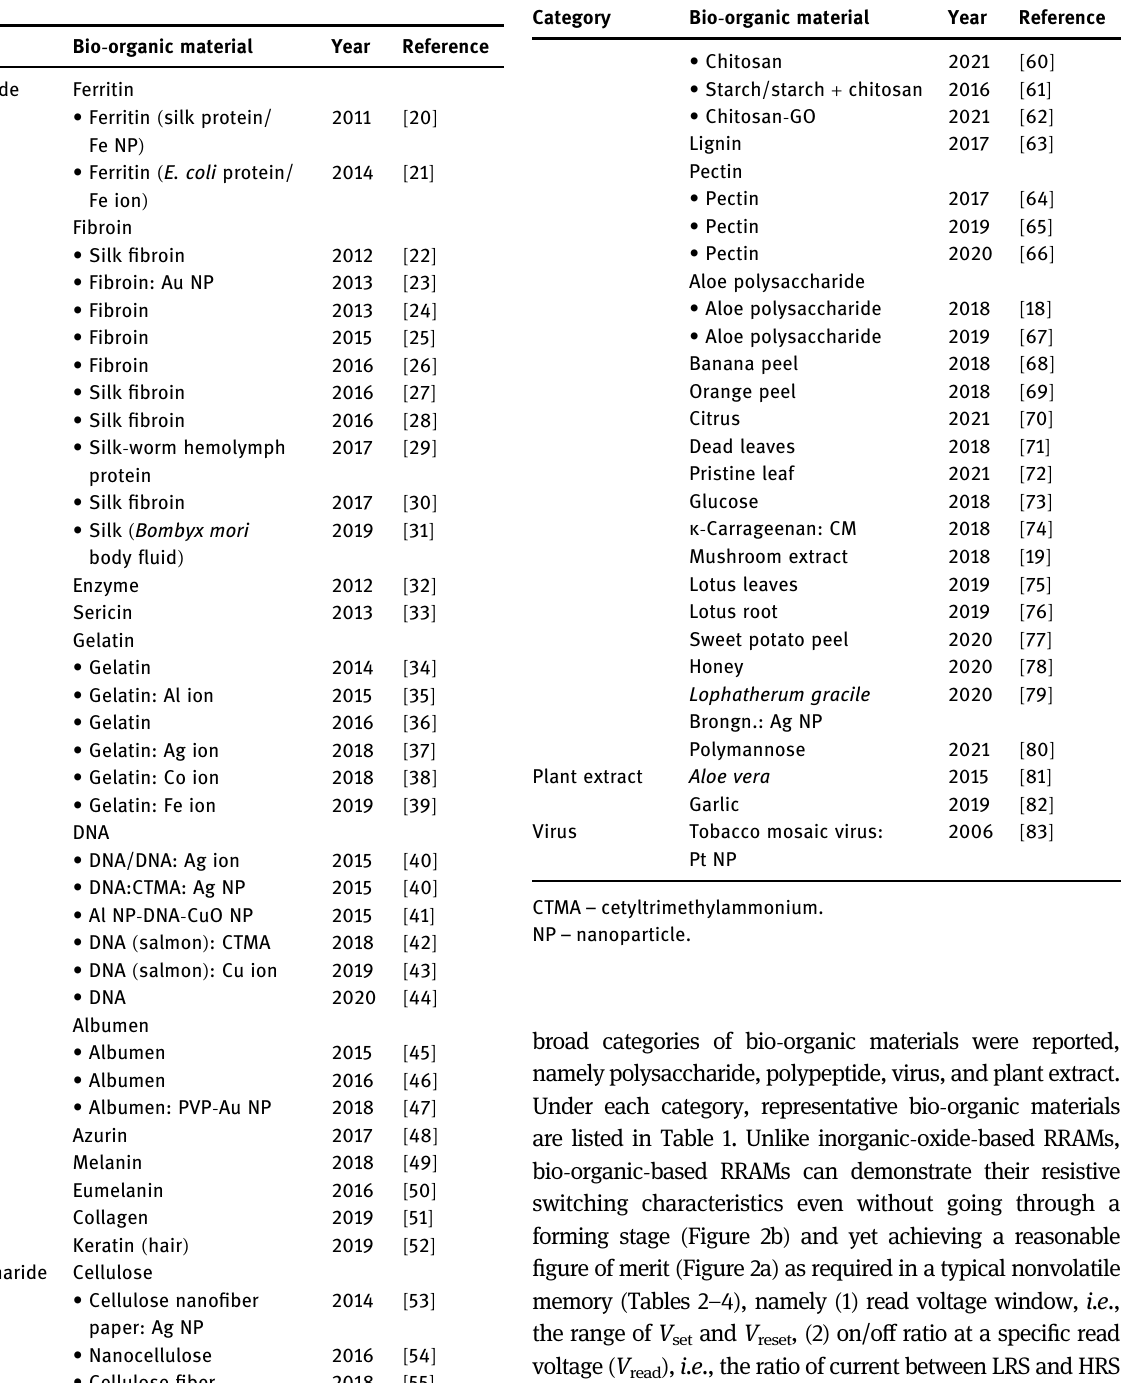
Table 1: Category of bio - organic materials reported as an active thin fi lm for resistive switching